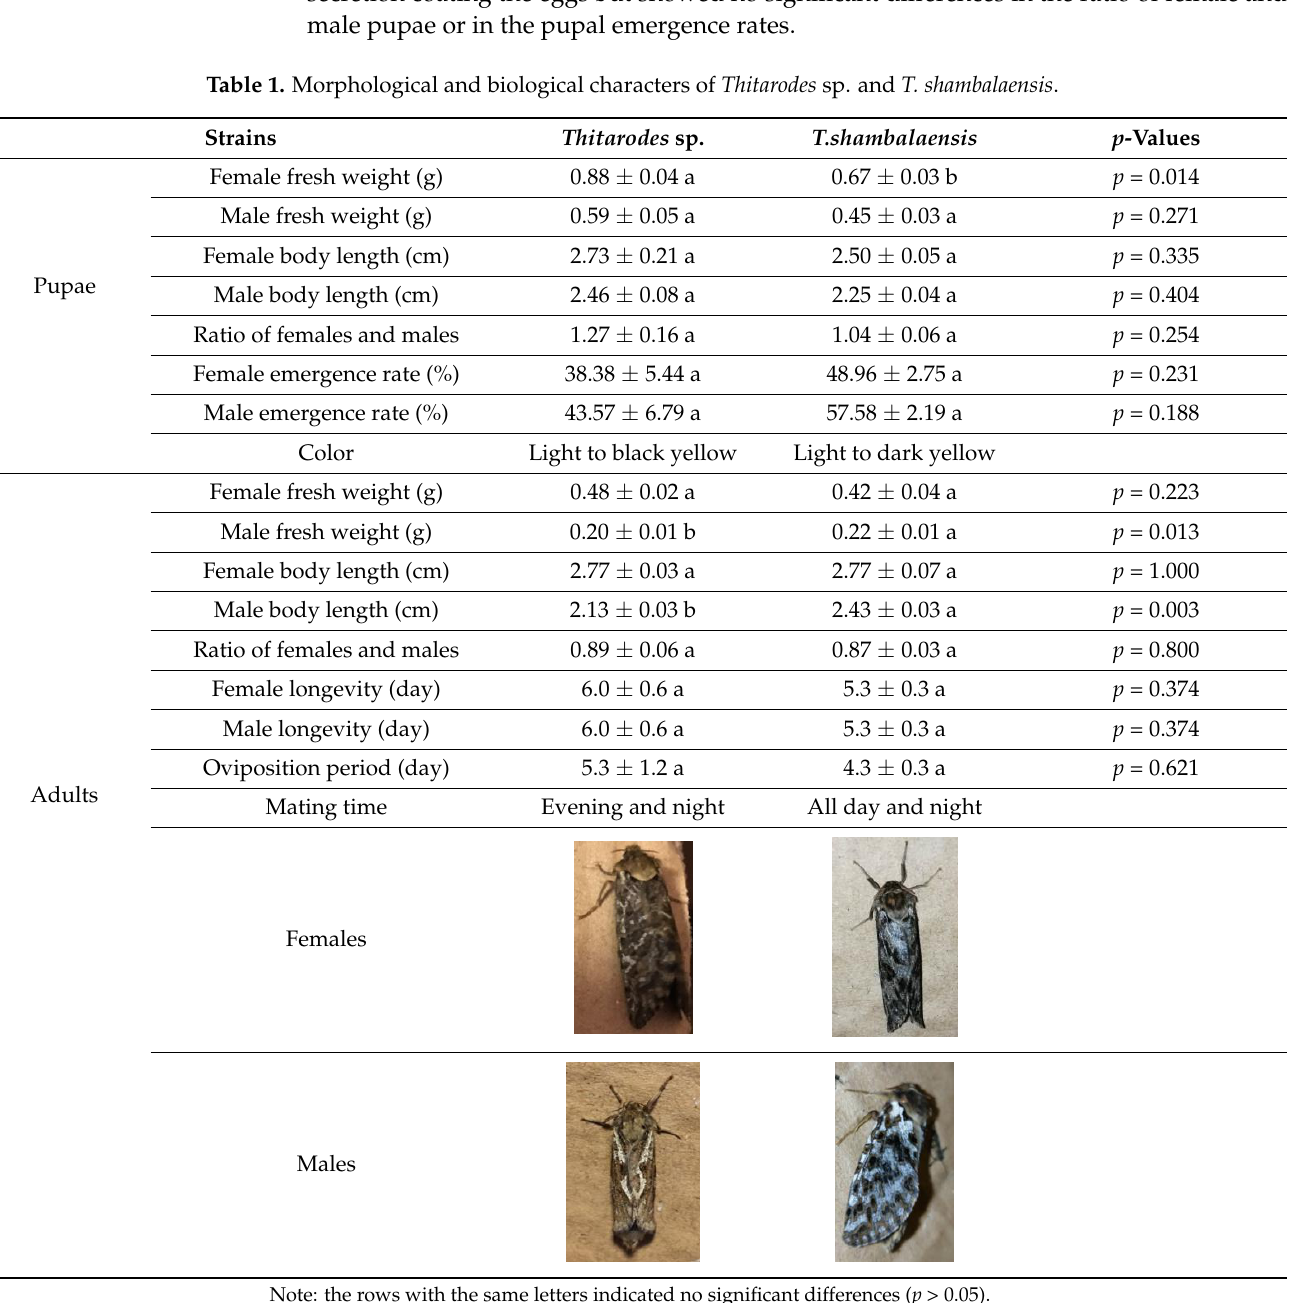
Table 1. Morphological and biological characters of Thitarodes sp. and T. shambalaensis. Strains Thitarodes sp.